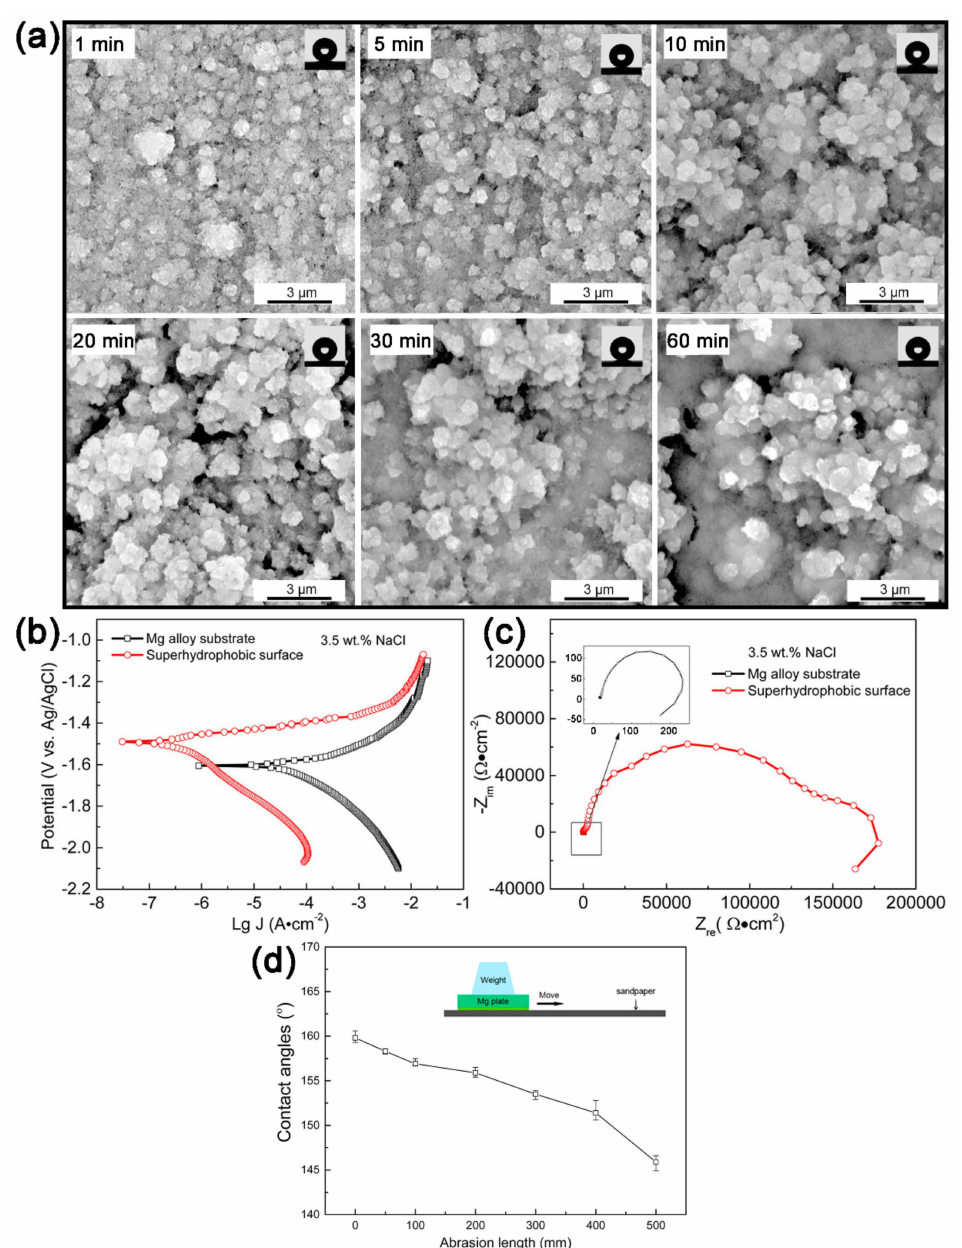
Figure 13. ( a ) SEM images and corresponding WCAs of the super-hydrophobic surfaces with various electrodeposition times: 1, 5, 10, 20, 30, and 60 min; ( b , c ) Potentiodynamic polarization curves and Nyquist plots of the untreated and super-hydrophobic Mg alloy surfaces in 3.5 wt % NaCl solution; ( d ) Schematic of the abrasion test and contact angles of the super-hydrophobic surface as a function of abrasion length. Reprinted with permission from [11]. Copyright (2015), American Chemical